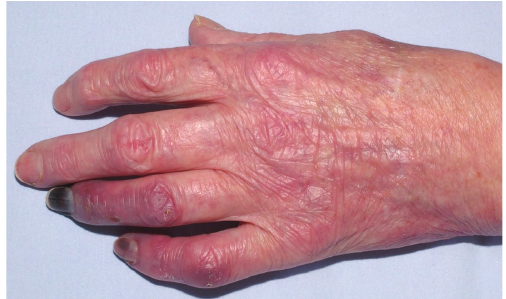
Figure 3: Demarcated necrosis of the 4th and 5th fingers after 5 weeks.